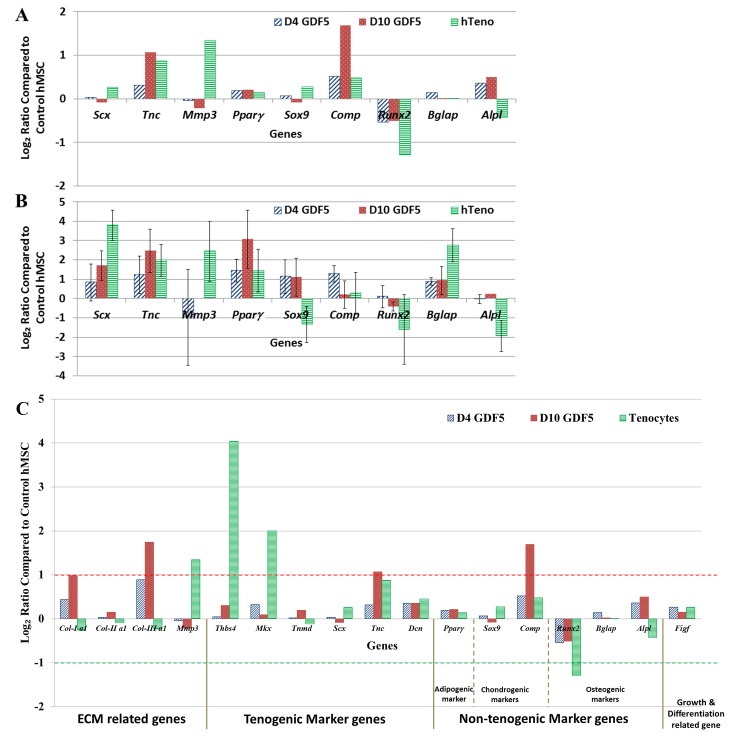
Expression levels of selected candidate tenogenic and non-tenogenic marker genes (total of nine genes) based on microarray and QuantiGene® Plex 2.0 Assay.(A) The graphical representation of genes expression patterns in hMSCs in response to GDF5 induction; with their respective log2 ratio based on microarray analysis. (B) Gene expression profiles independently validated using QuantiGene® Plex assay presented in log2 ratio. Expression variation for each gene was visualized with standard deviation. Considering that Scx and Mmp3 were derived from three biological samples compared to that of microarray which was derived from six bioloigical samples, the variation in the expression profiles was not unexpected. Whereas the Pparγ, Sox9, Comp and Bglap were all weakly expressed genes (the non-tenogenic marker genes), thus the differences detected may result from the detected limit and sensitivity of the different platforms, which subsequently affected interplatform reproducibility of differentially expressed genes. (C) Expression levels of the ECM related, candidate tenogenic and non-tenogenic marker genes based on microarray analysis. The graphical representation of genes (n = 16) displaying changes in expression patterns in hMSC in response to GDF5 induction with their respective log2 ratio based on microarray analysis. The genes which showed at least fold change of 2 (log2 ratio = 1, red dotted line) and fold change of less than 0.5 (log2 ratio = -1, green dotted line) were regarded as significantly up- and down- regulated genes respectively.